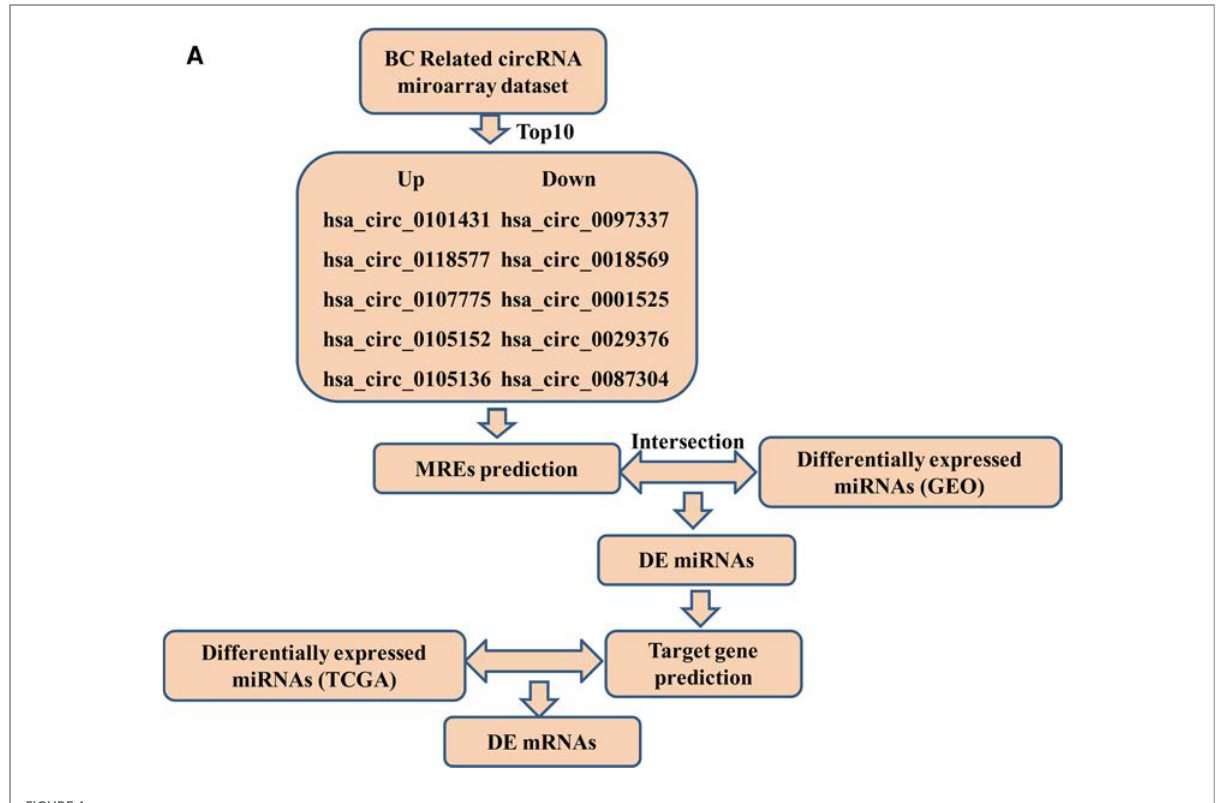
FIGURE 1 Flow chart of the ceRNA network